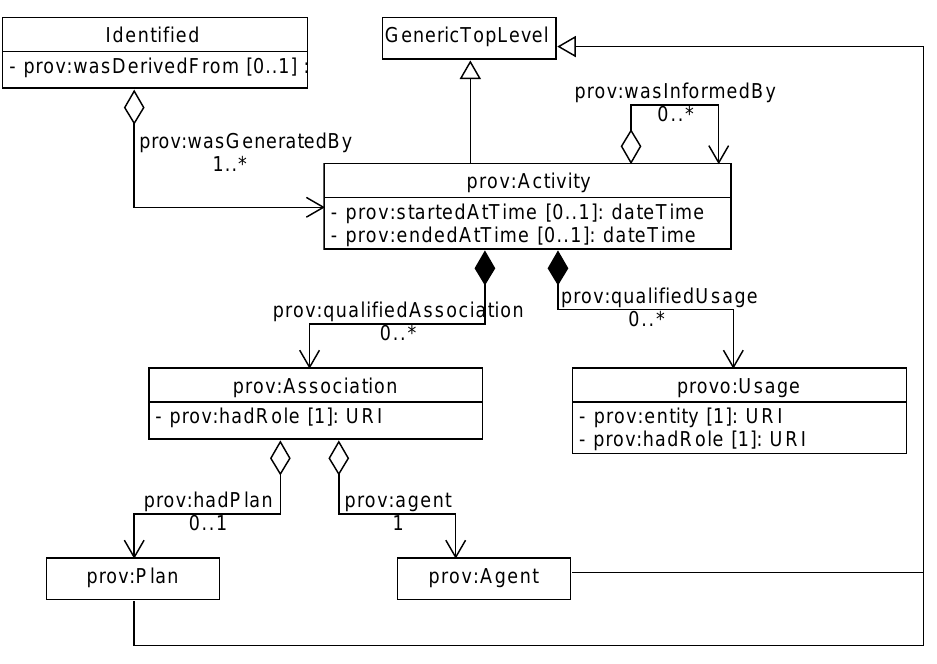
Figure 29: Relationships between SBOL and PROV-O classes. PROV-O specific classes and terms are prefixed with provo